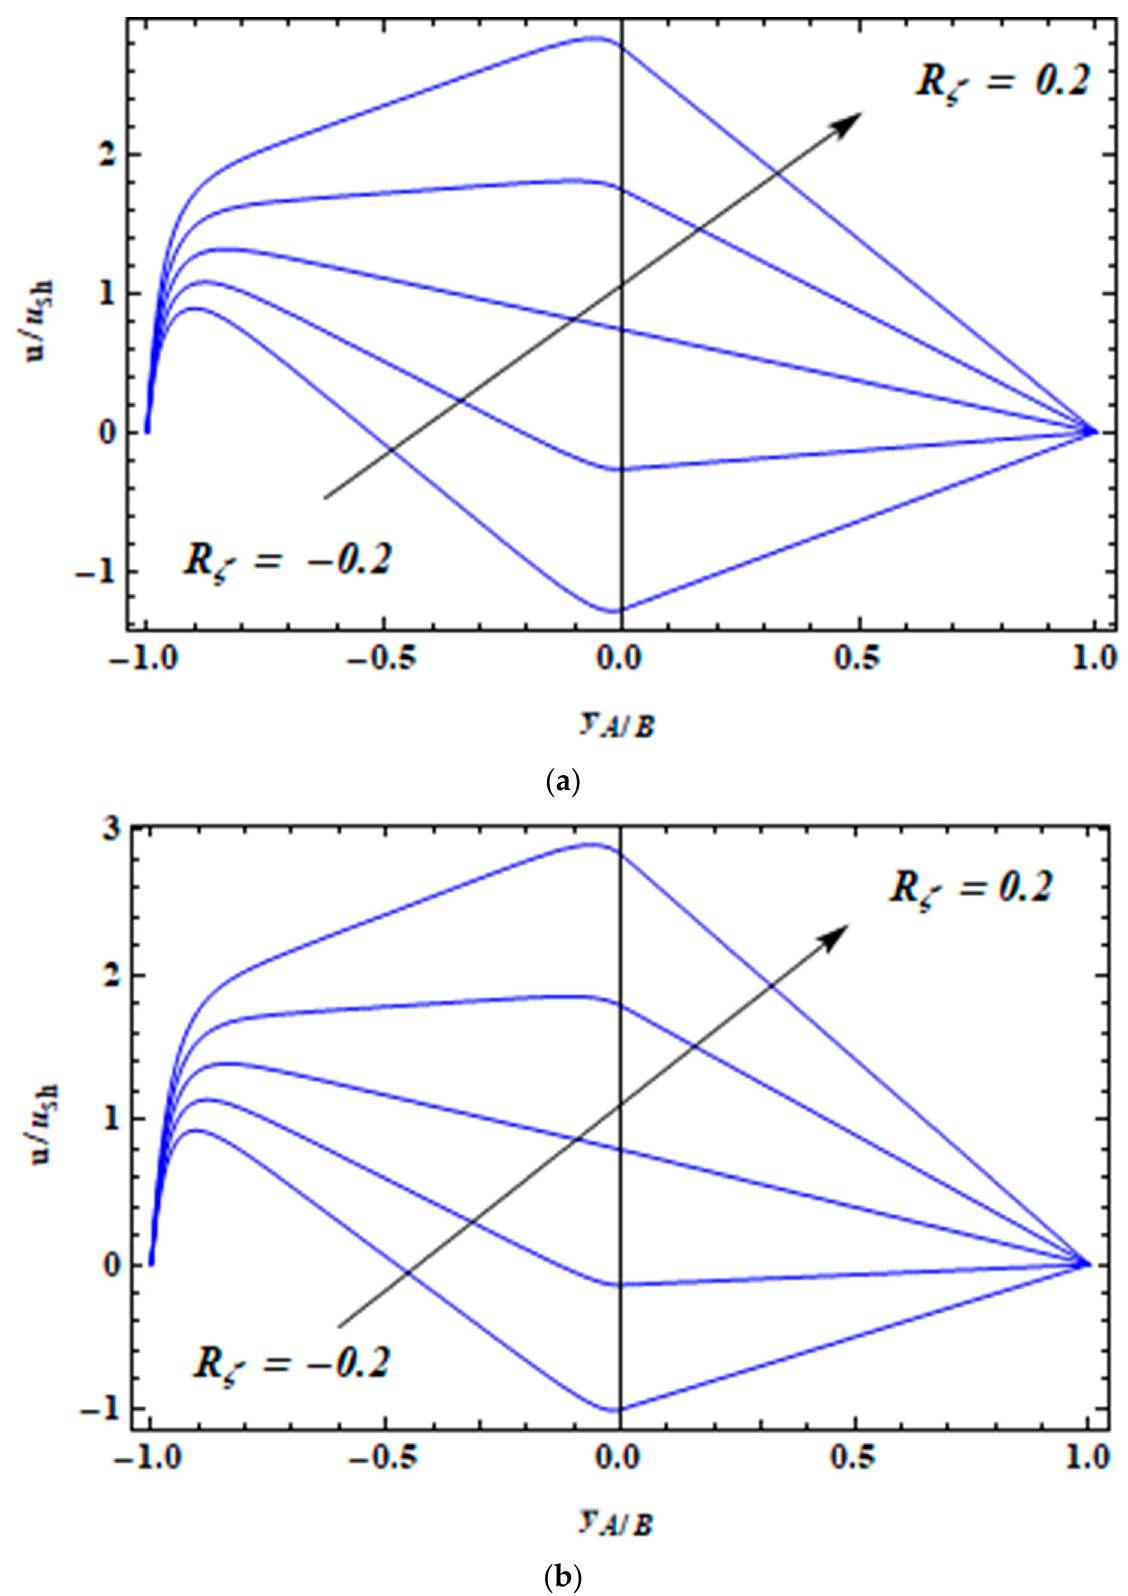
(cid:2869) = ; ( b ) 𝛽 = 1; 𝛤 = 0; 𝑅 = 20; 𝑅 (cid:3002) (cid:2870)